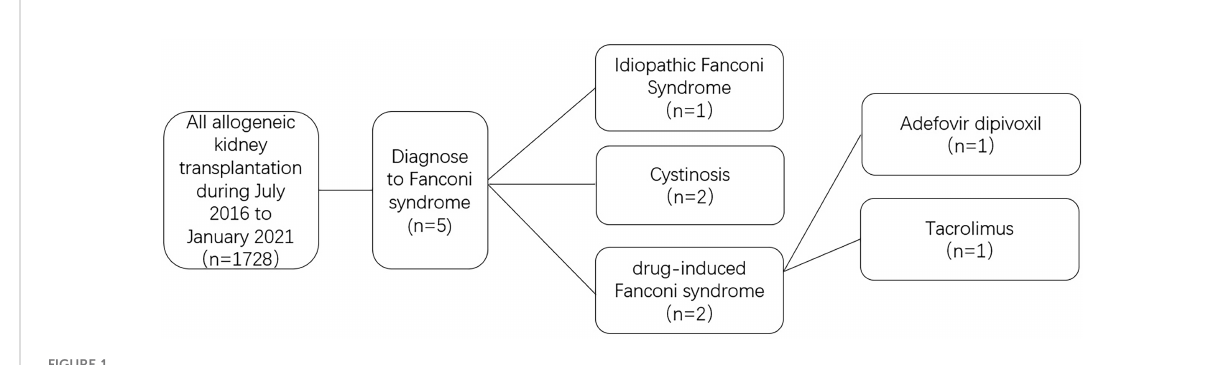
FIGURE 1 Flow chart of patient